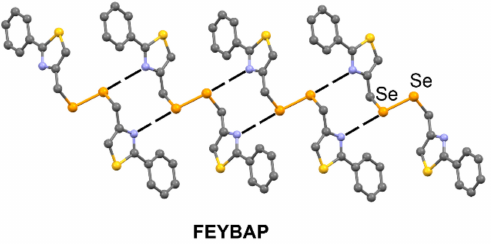
Figure 11. Ball-and-stick representation of the X-ray solid-state structure of FEYBAP showing the ChBs represented using dashed lines. H atoms omitted for clarity.